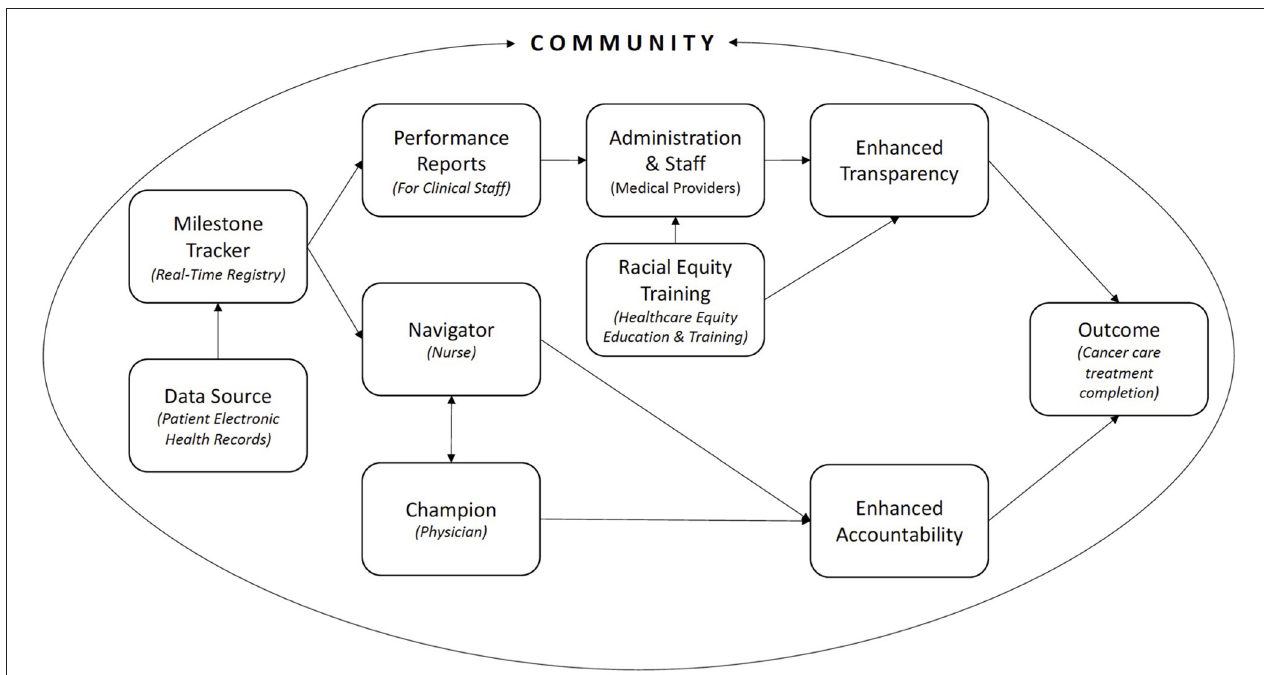
FIGURE 1 | ACCURE component: from real-world data to enhanced transparency and accountability.